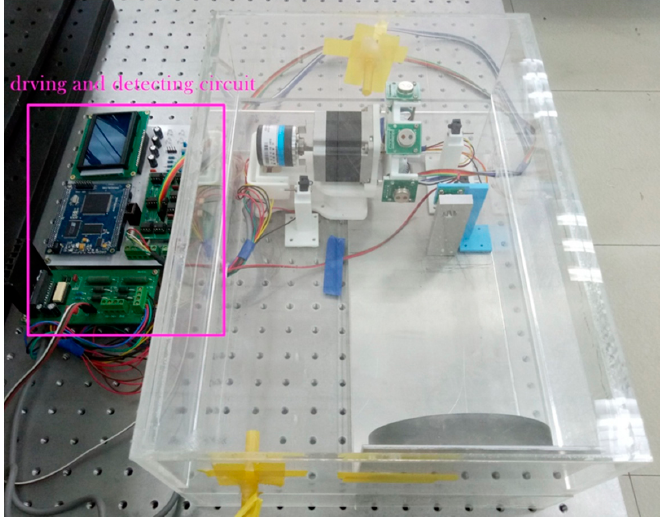
Figure 5. Measurement setup depicting the electrical and optical parts. The optical part was placed inside an enclosure.